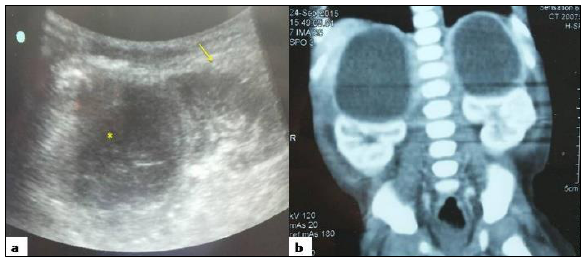
Figure 1: Case 1, a. Abdominal USG showing supra renal hypo- echoic mass with internal echoes and debris (asterix) with inferior displacement of kidney (arrow) b. Abdominal computed tomography image (coronal section) showing well-circumscribed, thin-walled, peripheral-enhancing cystic lesions in bilateral suprarenal areas with inferior displacement of bilateral kidneys.